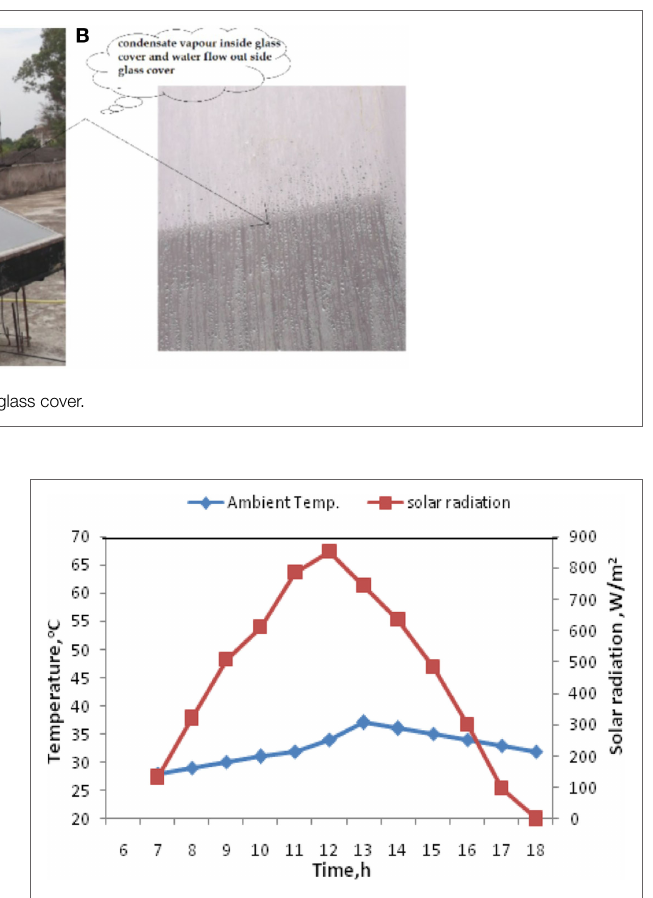
FIGURE 3 | Hourly profile of solar radiation and ambient temperature with